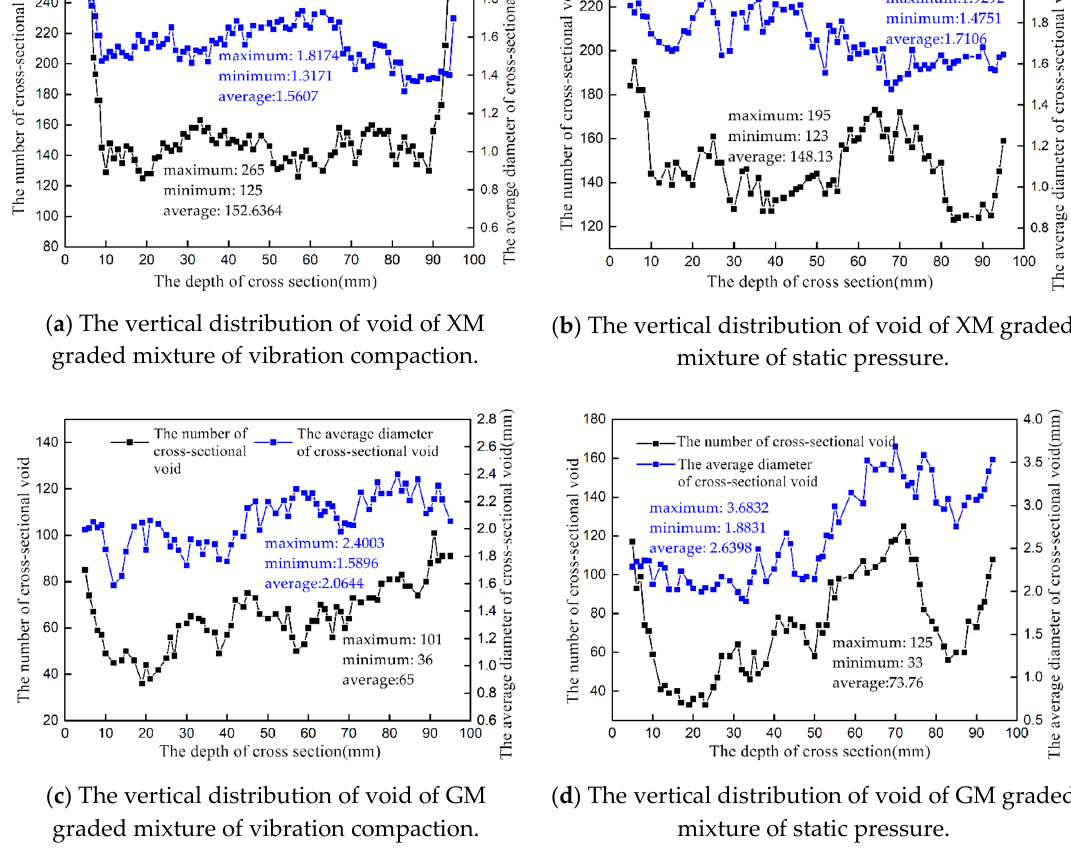
Figure 5. The vertical distribution of void of mixture.